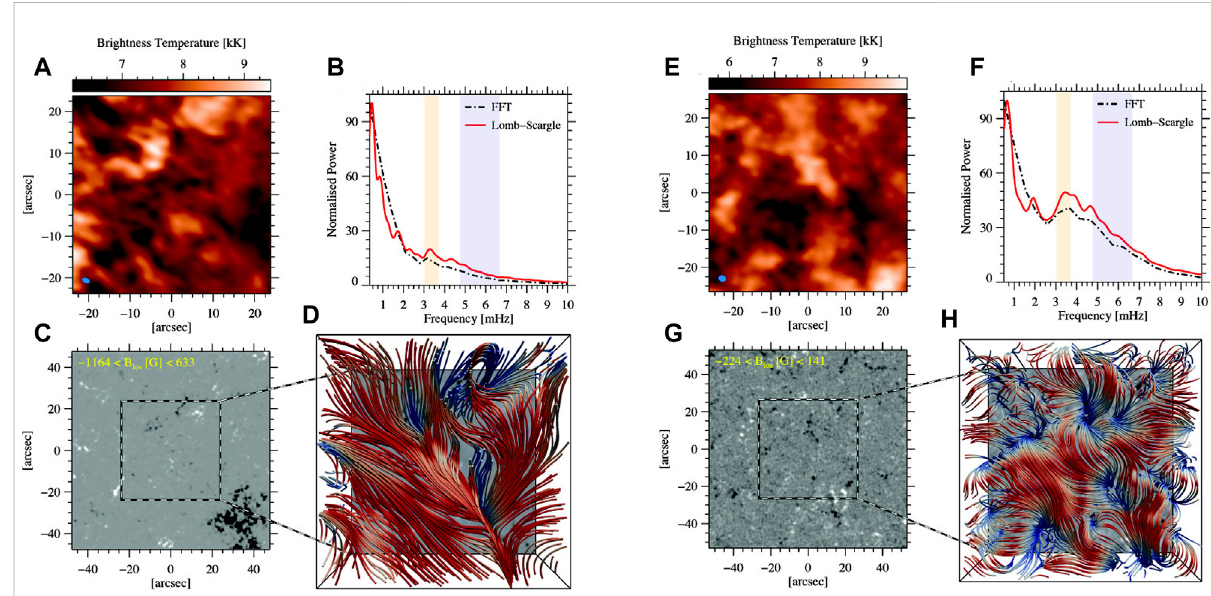
FIGURE 2 Panels (A – D) : the 22 December 2016 Band 3 dataset used for the detection of mm- λ oscillations. (A) An ALMA brightness temperature map in Band 3. (B) Spatially averaged brightness temperaturepower spectra from FFT (dash-dotted black line) and Lomb-Scargle (solid red line) transforms. Periodrangescorrespondingtothe3and5 minwindows(eachwithawidthof1 min)arerespectivelydepictedwiththepurpleandyellowstripes. (C) The SDO/HMI line-of-sightphotospheric magnetogramfor aFOV twice as large as ALMA ’ s.The ALMA ’ sFOV ismarked with